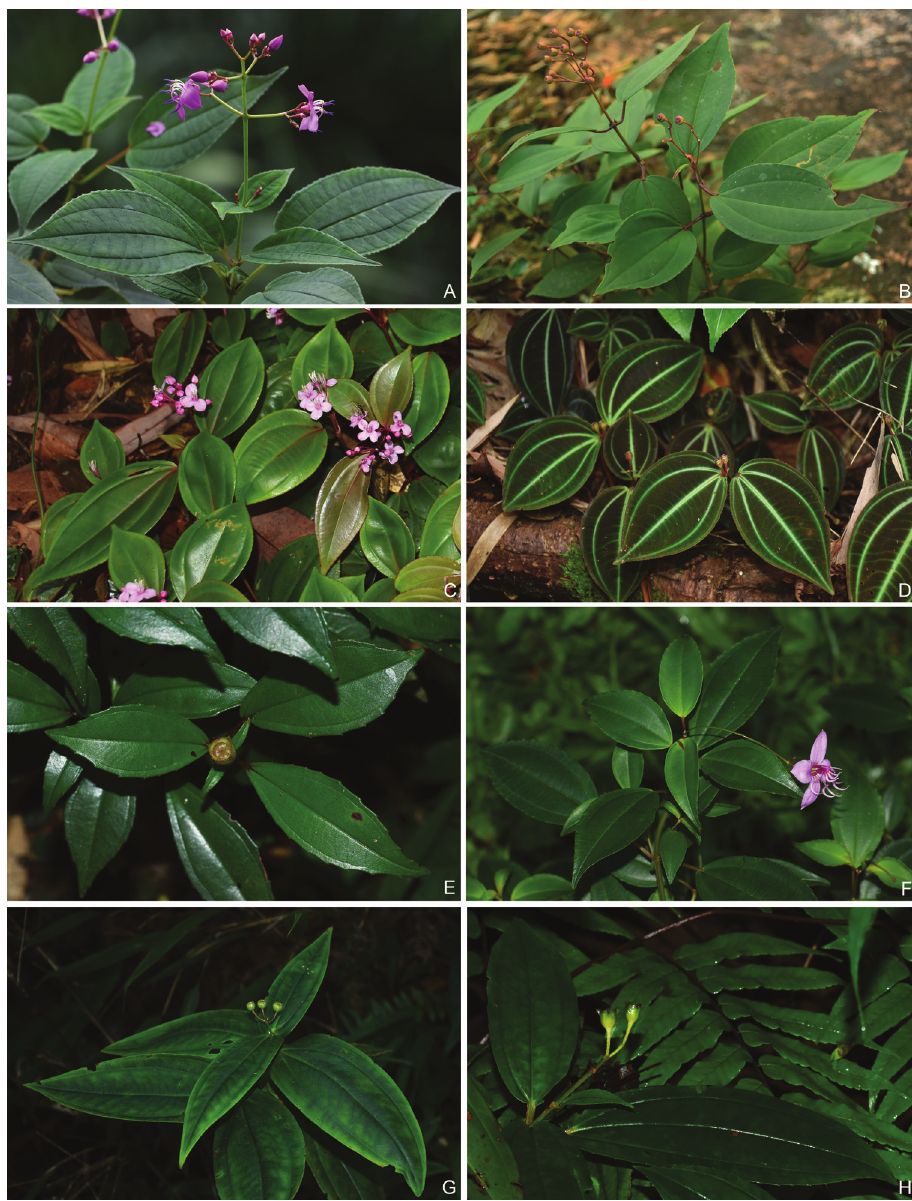
Figure 2. Leaf morphology of the Tashiroea clade. A T. amoena ( Y. Liu 571 ) B T. biglandularis ( Y. Liu 553 ) C T. nudipes ( Y. Liu 435 ) D T. oligotricha ( Y. Liu 468 ) E T. okinawensis ( Y. Liu 636 ) F T. quadran- gularis ( Y. Liu 585 ) G T. sessilifolia ( Y. Liu 540 ) H T. yaeyamensis ( Y. Liu 631 uniseriate/multiseriate trichomes with or without glandular heads (Fig. 5A–C, E–H). Yellowish uniseriate trichomes (branched or unbranched) (Fig. 5D), are present only in the Tashiroea clade, where they occur on apical and axillary buds and sometimes on young leaves and branches (Fig. 5M–P). Both clades are quite variable in terms of leaf